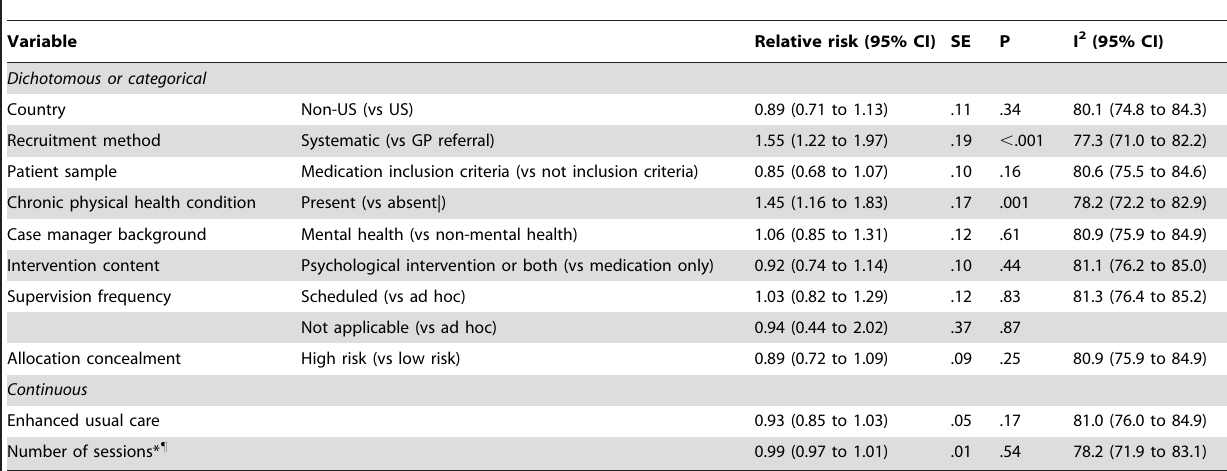
Table 6. Univariable predictors of antidepressant use (N=